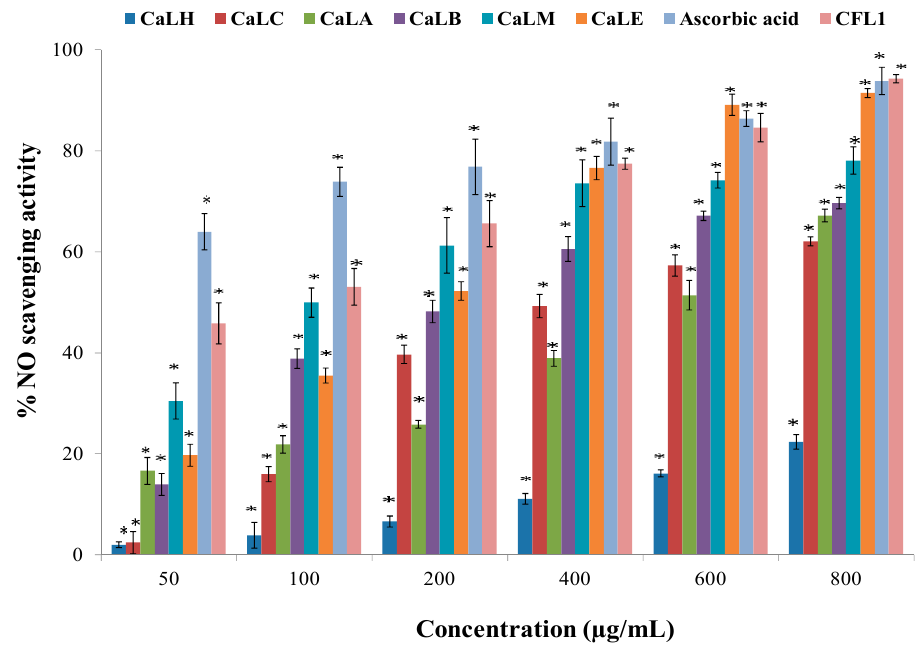
Figure 2. Nitric oxide radical scavenging effects from extract/fractions from C. fistula and standard ascorbic acid (values are represented as percent of control). * indicates a statistically significant difference at ( p ≤ 0.05) (For each fraction n = 18).